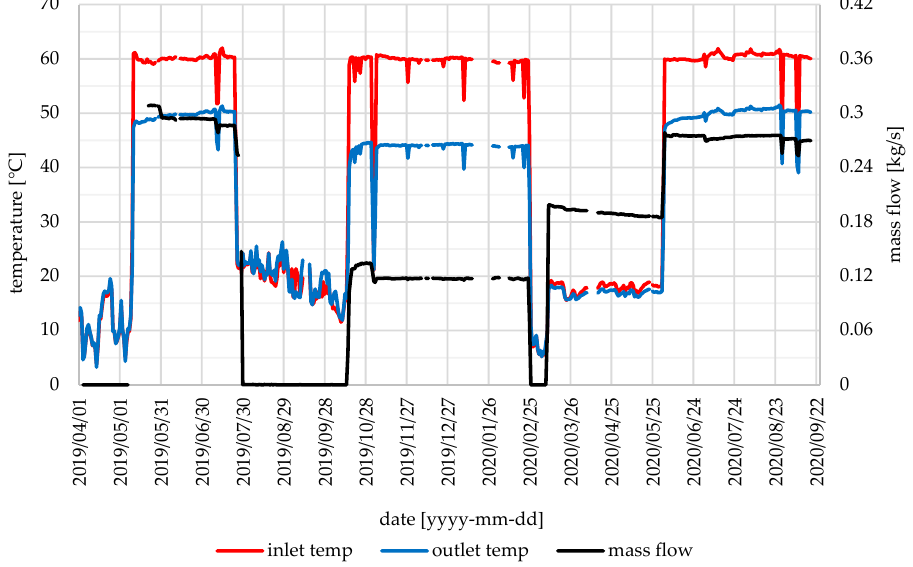
Figure 17. Inlet, outlet, and volume flow profiles of the experimental borehole BOHR2. Temperature measurements were made inside the aboveground heating cell used to charge BOHR2. Temperatures recorded during zero flow conditions are representative of atmospheric conditions as the sensors were outdoors and